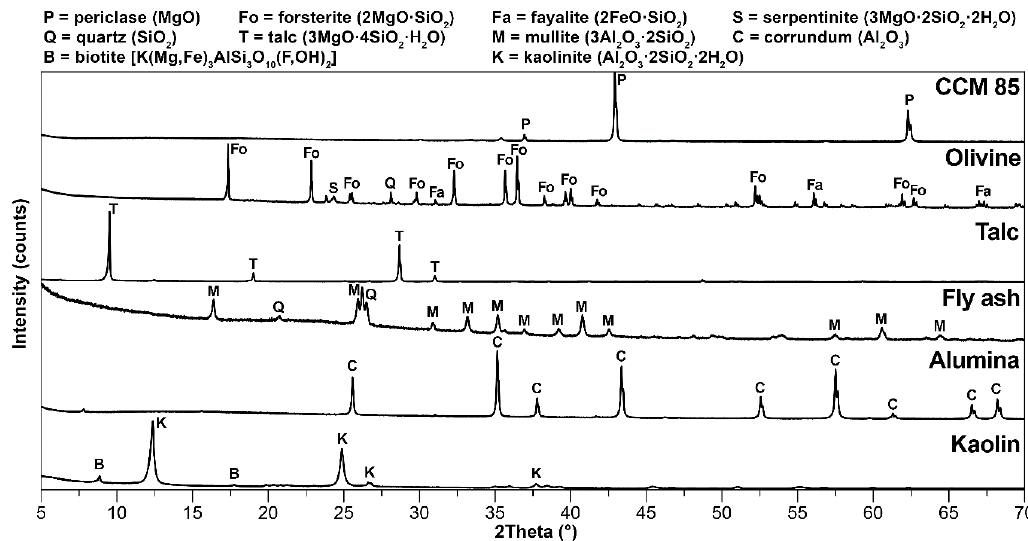
Figure 1. X-ray diffraction analysis of raw materials. The scanning electron microscope (SEM) microphotographs of all untreated raw ma- terials are presented in Figure 2a – f. The particles in CCM agglomerated together, with a particle size in a range of 5 – 50 µm. Untreated olivine has an apparent fibrous microstruc- ture. Particles in talc have a foliated or fibrous microstructure, with different size flakes. The reactive alumina is composed of fine particles with d 50 = 1.9 µm and that tend to clus- ter together. The untreated coal fly ash is mainly composed of spherical particles ranging in size, with a diameter of 0.4 – 90 µm (d 50 = 14 µm). Kaolin platelets are clustered together in a general sheet appearance. ( a )